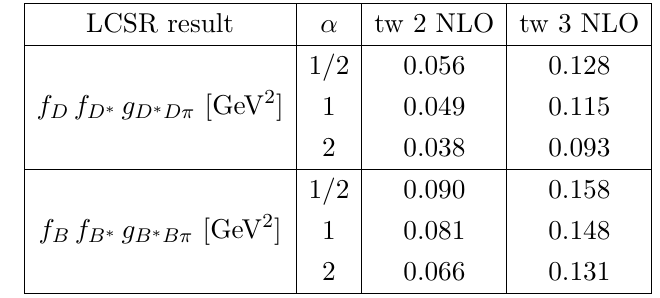
Table 5 . Numerical results for different duality regions at central values of